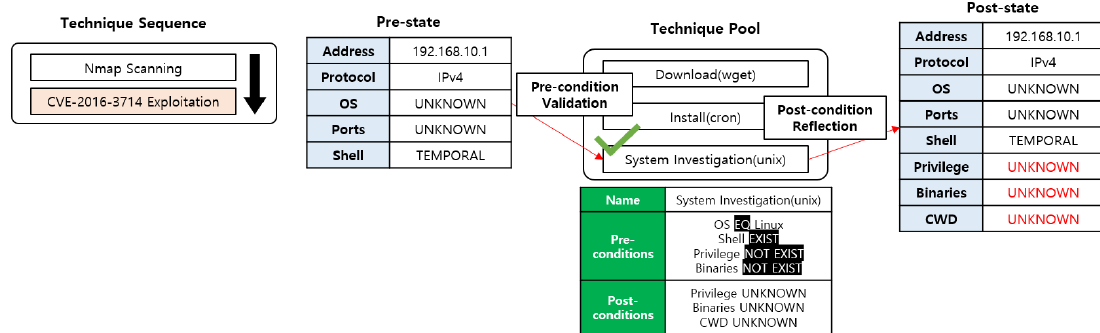
Figure 3. The example of the process of scenario generation: CVE-2016-3714 exploitation chosen.